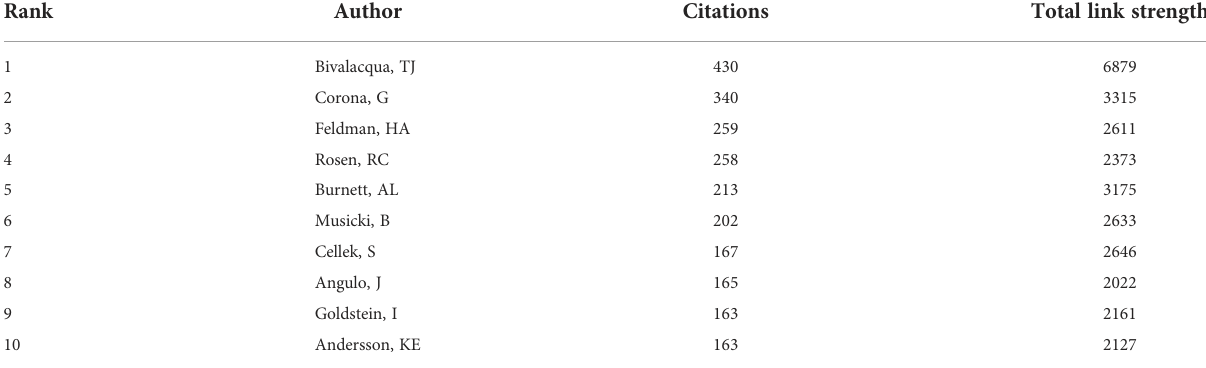
TABLE 6 The number of co-citations of the top 10